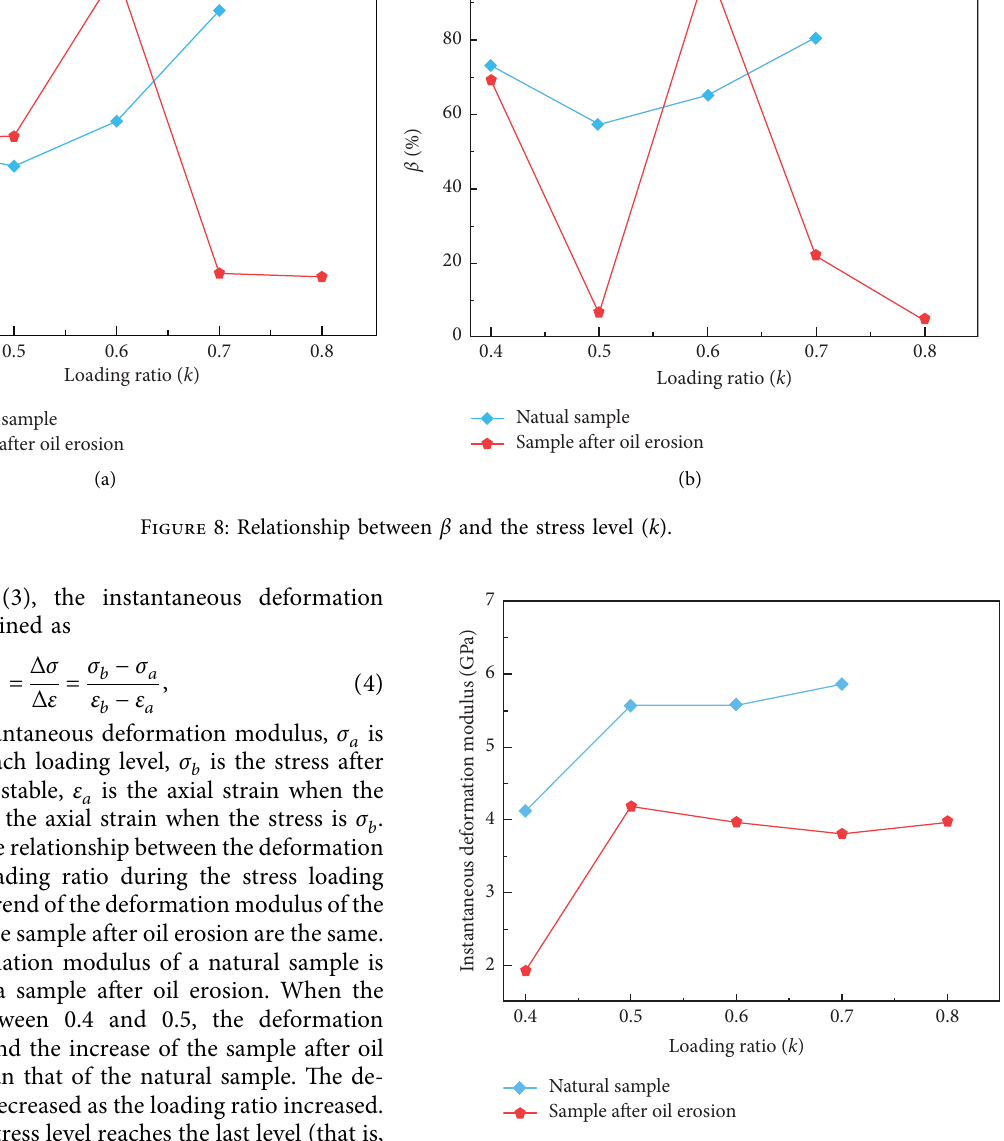
Figure 9: Te relationship curve between the deformation mod- ulus and the loading ratio during the creep